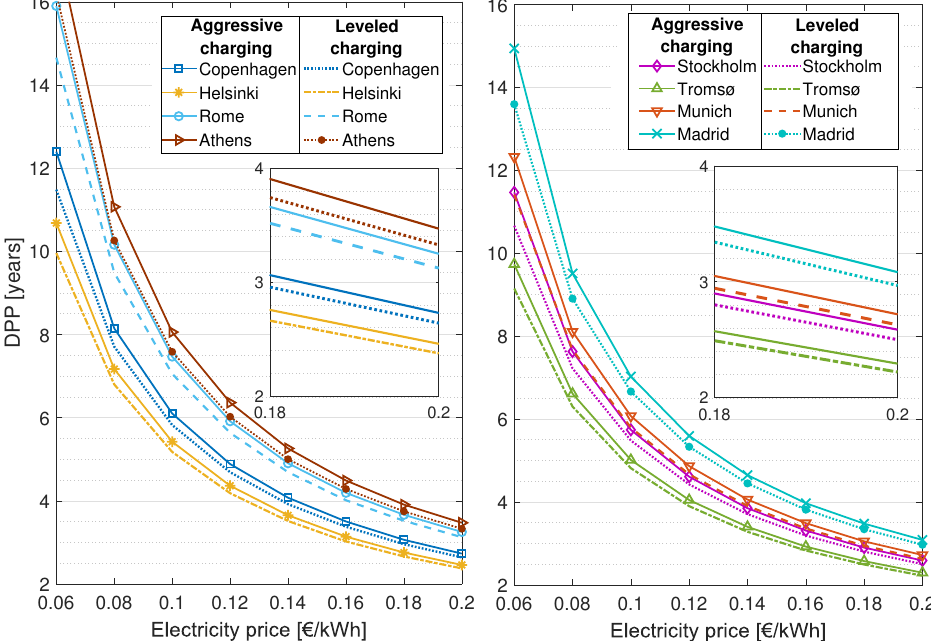
Figure 12. Discounted payback period for selected cities with the SC design at different electricity prices when applying the leveled and aggressive charging strategy.